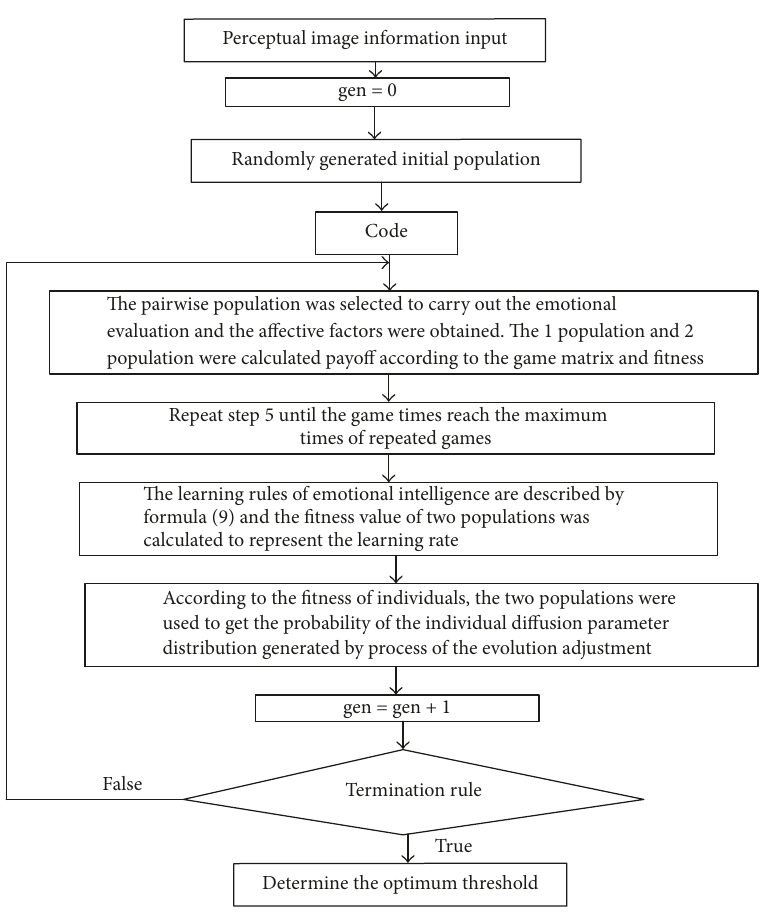
Figure 4: Evolutionary algorithm based on the mechanism of protein